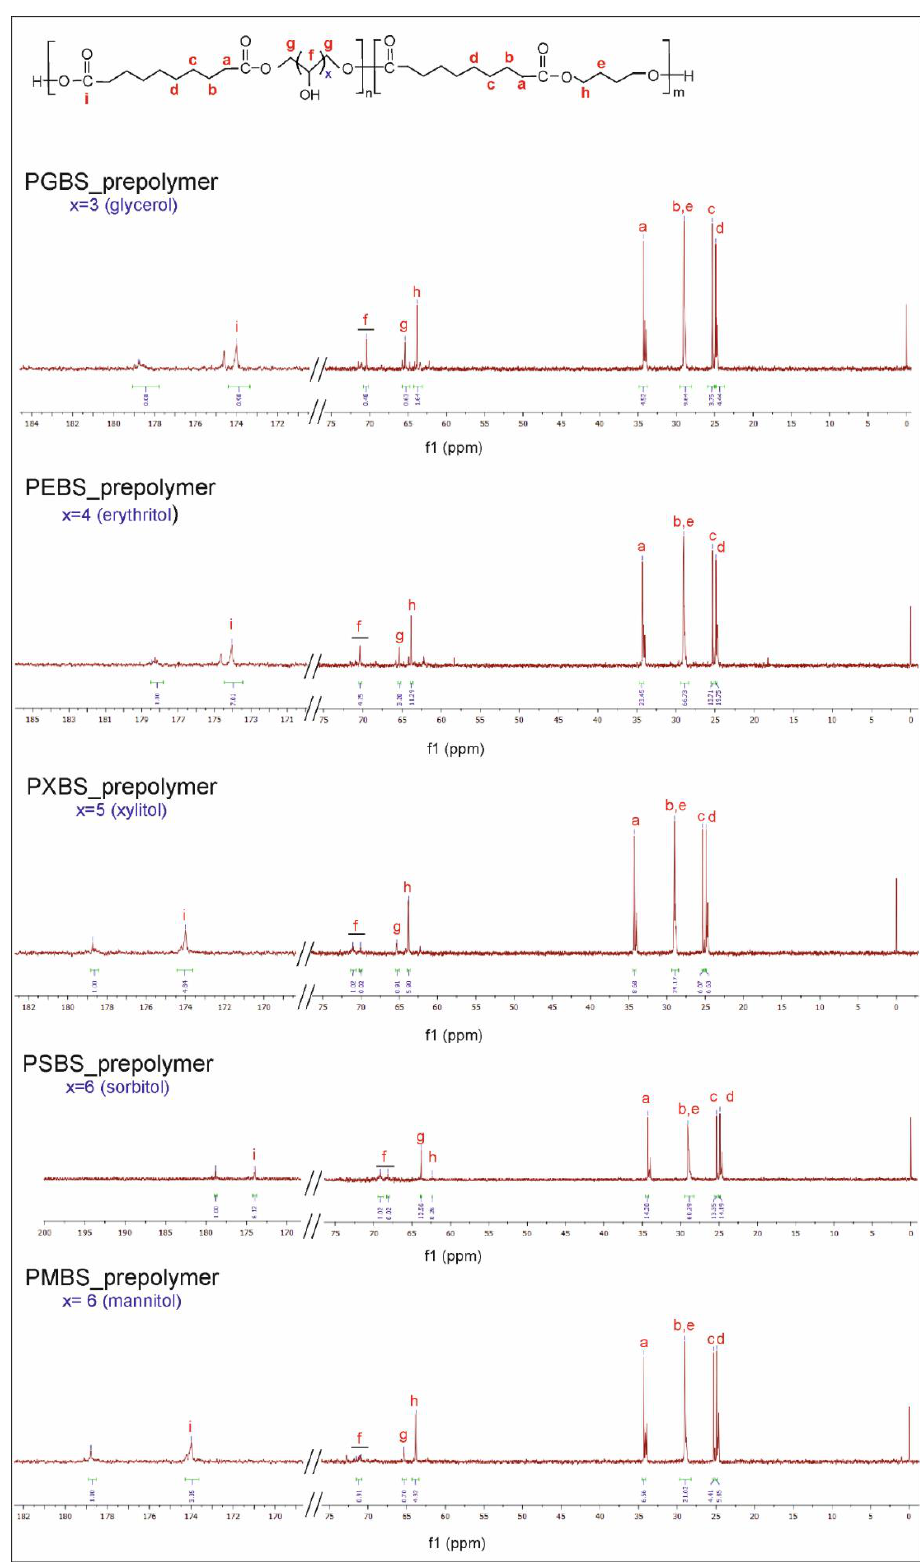
Figure 3. 13 C NMR of PGBS, PEBS, PXBS, PSBS, and PMBS prepolymers.